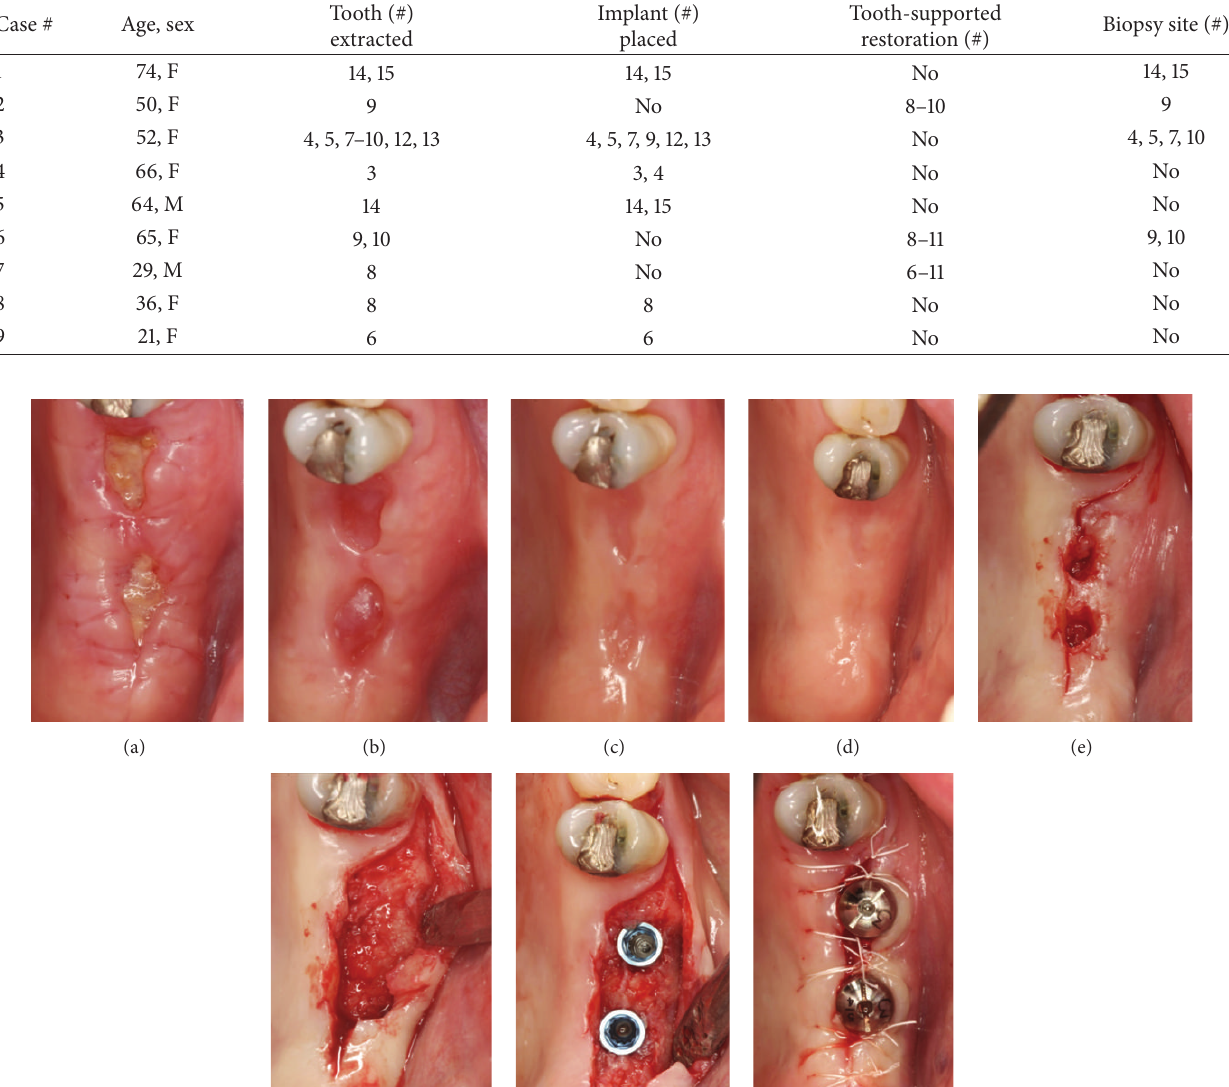
Table 1: Case demographics.